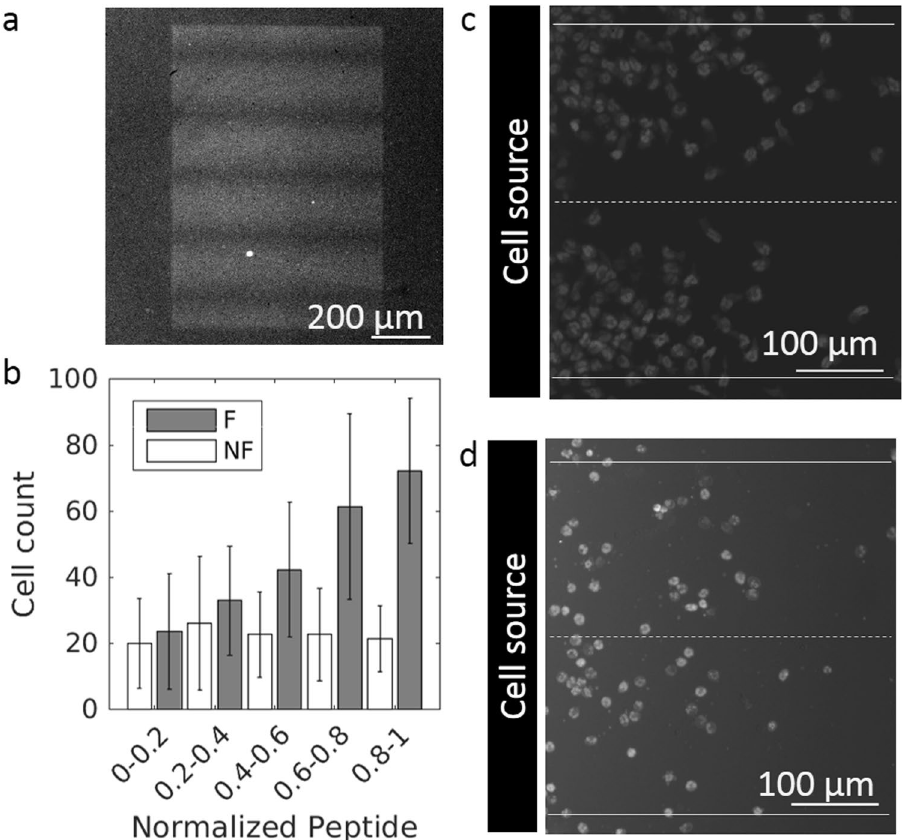
Figure 2. Neutrophil migration on substrate-bound peptide gradient. ( a ) Fluorescent image of typical surface-bound gradients. ( b ) Absolute cell count in binned regions of increasing normalized bound-peptide concentration of formylated (F) or non-formylated (NF) FITC-labeled NLFNTK. n = 3 replicates. Error bars represent SD. ( c and d ) Location of neutrophils on a formylated ( c ) or non-formylated ( d ) FITC-labeled NLFNTK pattern after 2 hours of migration. Dashed lines represent minima of gradient and plain lines